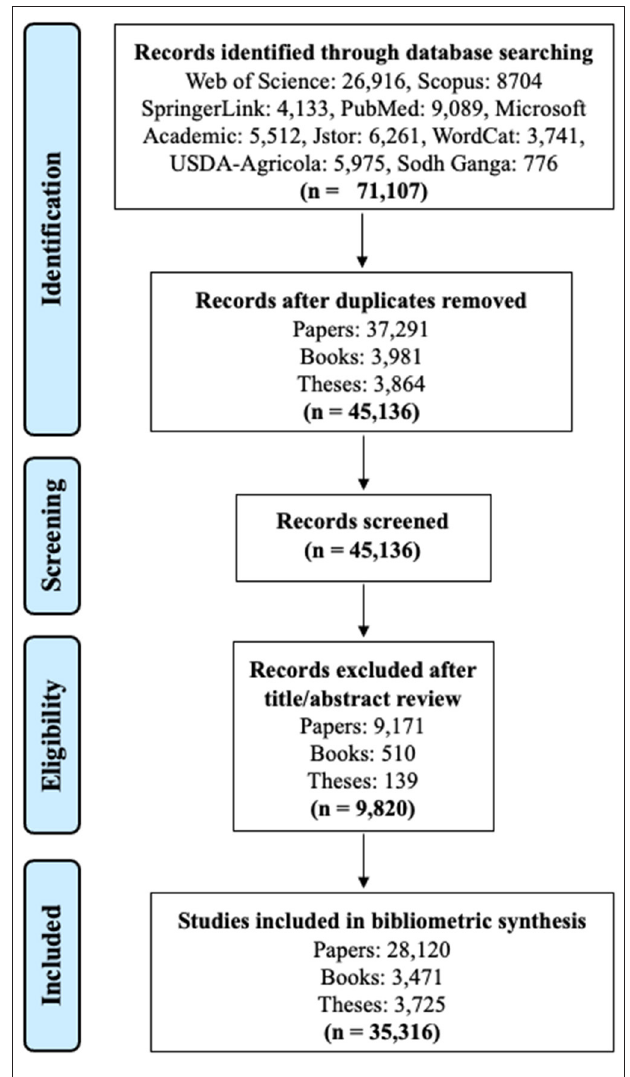
FIGURE 1 | PRISMA flow diagram of the systematic literature review on the biodiversity of the Himalaya